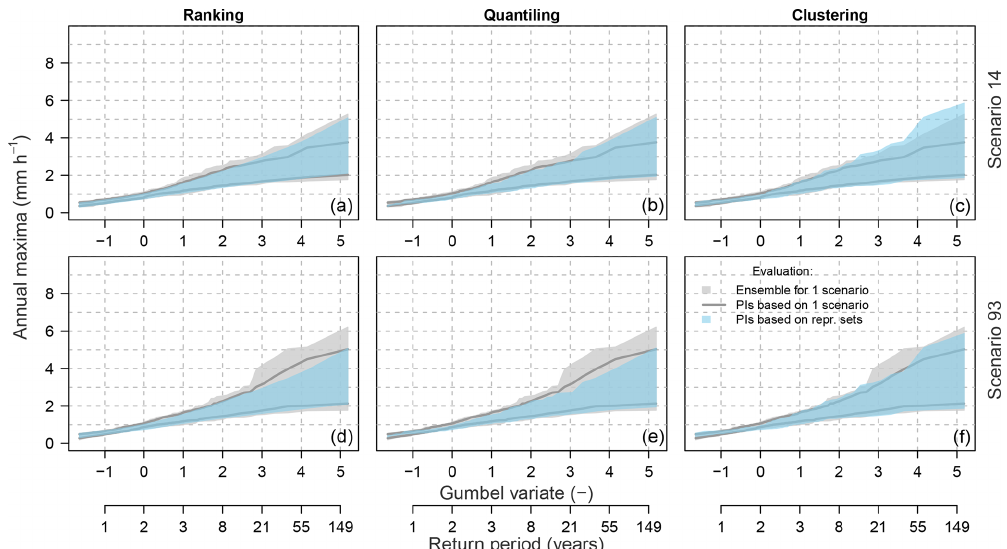
Figure 8. Example of leave-one-out cross-validation for the three selection methods and two meteorological scenarios. PIs represent the 90% predictive intervals.